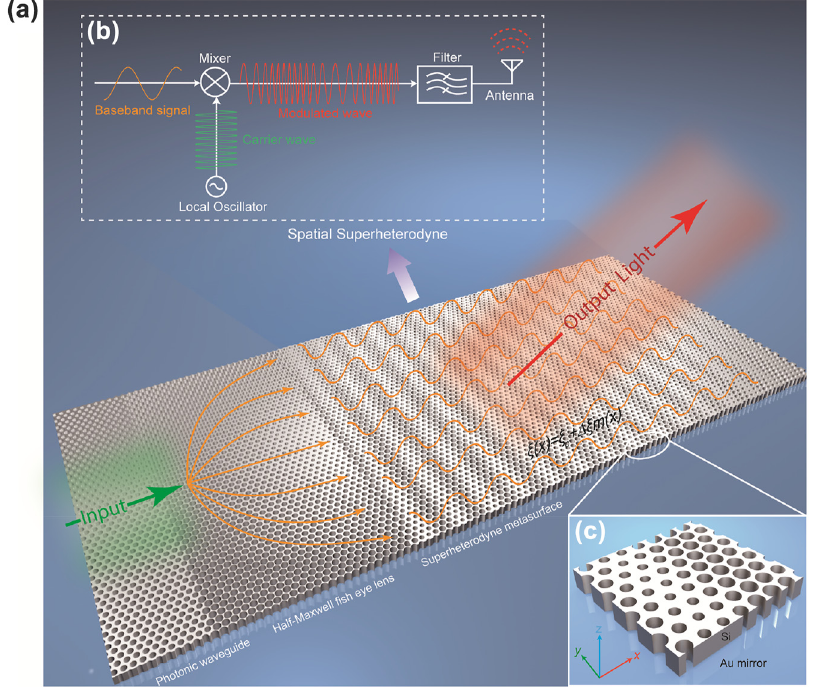
Figure 1: Conceptual illustration of the waveguide-integrated superheterodyne metasurfaces for free-space coupling. (a) Configurations of the whole metasurface, which consists of a photonic waveguide, planar half-Maxwell fish eye lens and superheterodyne metasurface – all implemented in a Si slab with air-hole cladding. The photonic waveguide and the planar half-Maxwell fish eye lens are utilized to guide and generate collimated guided waves to feed the superheterodyne metasurface. The superheterodyne metasurface can convert and mold the in-plane guided modes into any desired out-of-plane free-space modes. (b) The functionality of the metasurface can be interpreted as a spatial superheterodyne transmitter to perform spatial frequency modulation of the guided waves. New spatial harmonics are generated, but only the target spatial spectra, corresponding to the desired free-space modes, are selected by an equivalent spatial filter by the momentum matching condition and eventually radiate into free space. (c) The metasurface is implemented in the form of a 2D lattice of sub-wavelength air hole structure in a Si slab. An Au ground works as a mirror and provides mechanical support to the THz